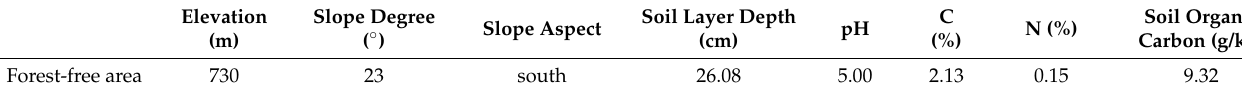
Table 1. Specific description of the forest gap.